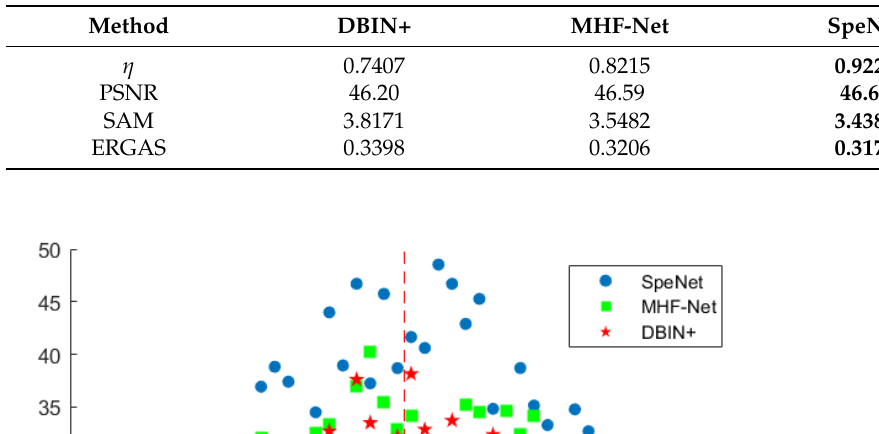
Table 1. Comparison of residual activity factors with PSNR, SAM and ERGAS in several super- resolution networks based on residual modules, where η is the defined residual activity factor. The best results are shown in bold.